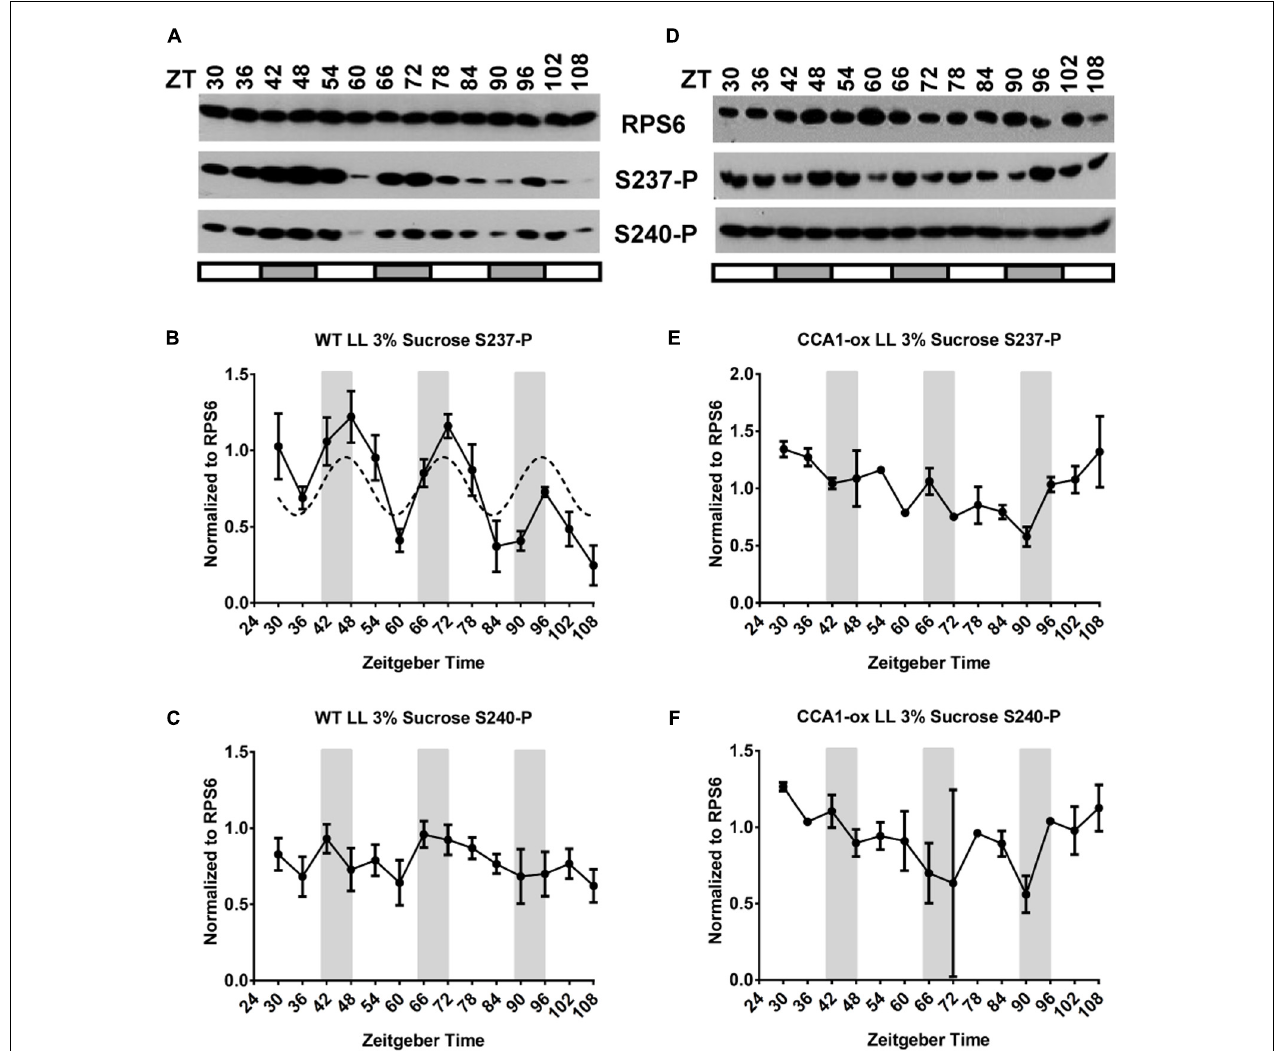
FIGURE 7 | RPS6-P at 3% sucrose under continuous light. (A–C) Wild-type. (D–F) CCA1-ox. Experiments were performed at least twice at different times. For details see legend to Figure 3